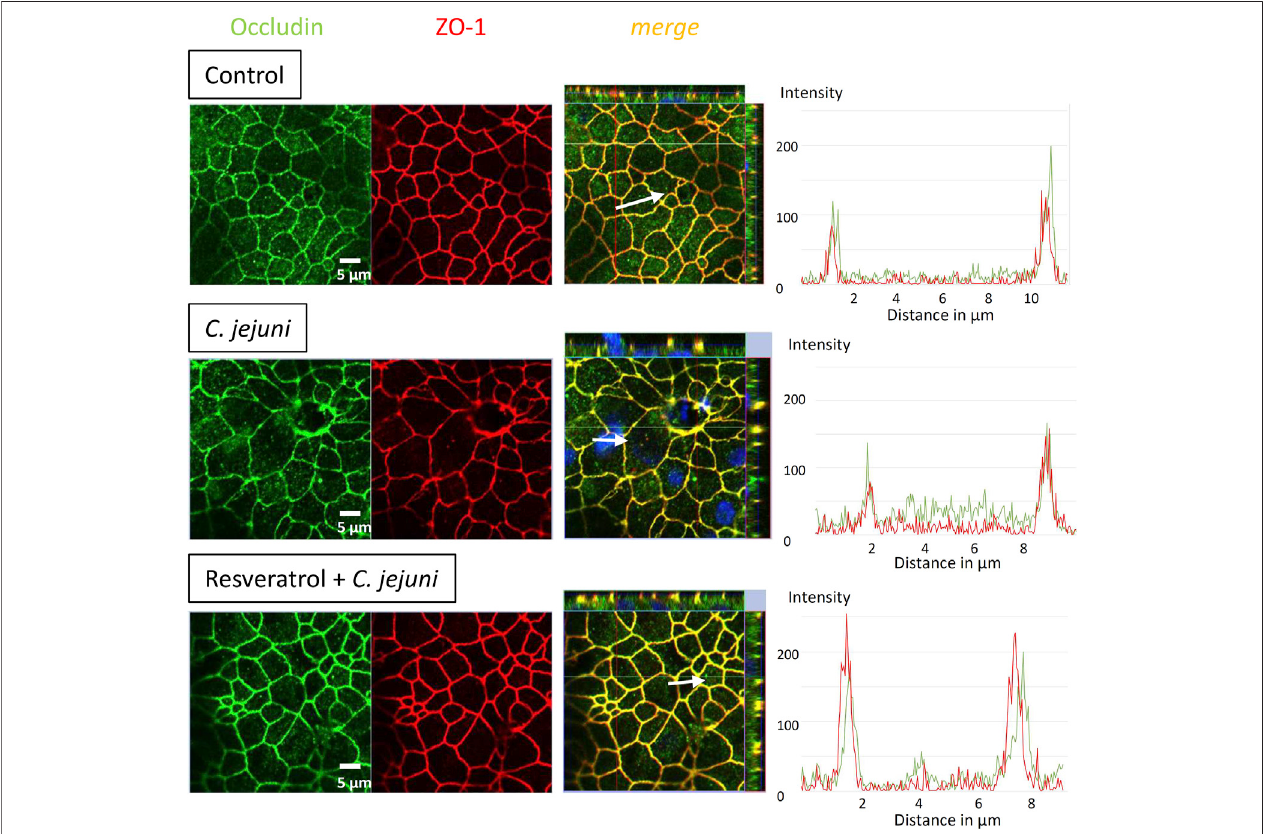
FIGURE3| Subcellulartightjunctionprotein distribution ofoccludinunder Campylobacter jejuni infectionandresveratroltreatment.Resveratrolmitigates C.jejuni - inducedre-distributionofoccludin.HT-29/B6-GR/MRcellsweretreatedwithresveratrolandinfectedwith C.jejuni fromapical.48 hpost-infectionmonolayersgrownon fi lter inserts were stained with antibodies against occludin (green) and zonula occludens protein-1 (ZO-1; red). Nuclei were stained with 4,6-diamidino-2-phenylindole (DAPI) in blue (bar 5 µm). Intensity plots point to signals of the TJ proteins indicated with white arrows in the merge pictures. The intensity signals appear highest in the TJ domain with a proper co-localization under control conditions and vary under infection and treatment conditions along the white arrows over single cells.